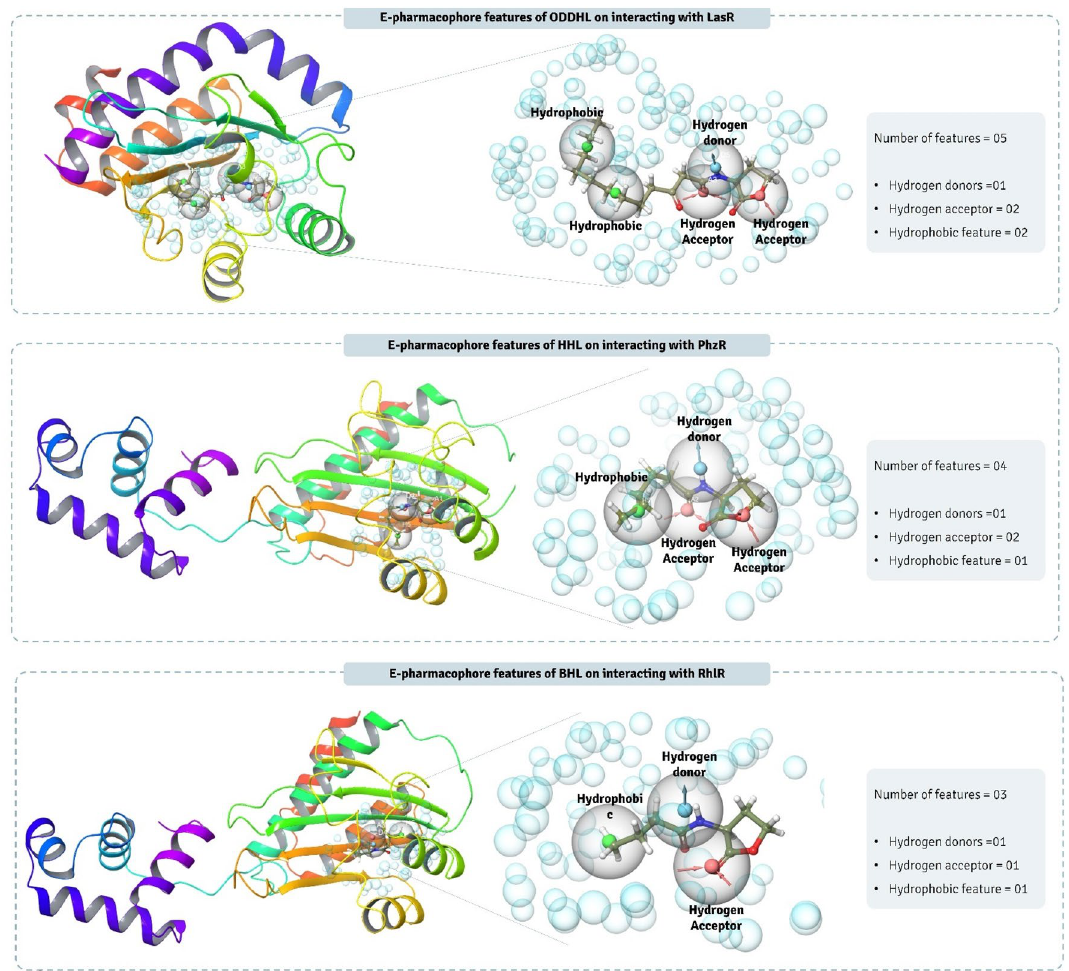
Figure 3. E-pharmacophore hypothesis of all the three complexes, LasR-ODDHL, PhzR-HHL and